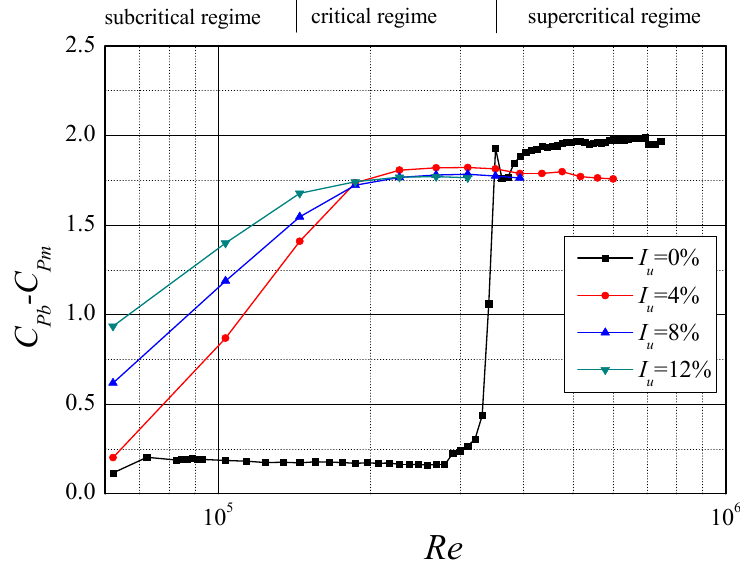
Figure 13 . Wind pressure rise coefficient C pb - C pm in the turbulent flow. Figure 13. Wind pressure rise coe ffi cient C pb - C pm in the turbulent